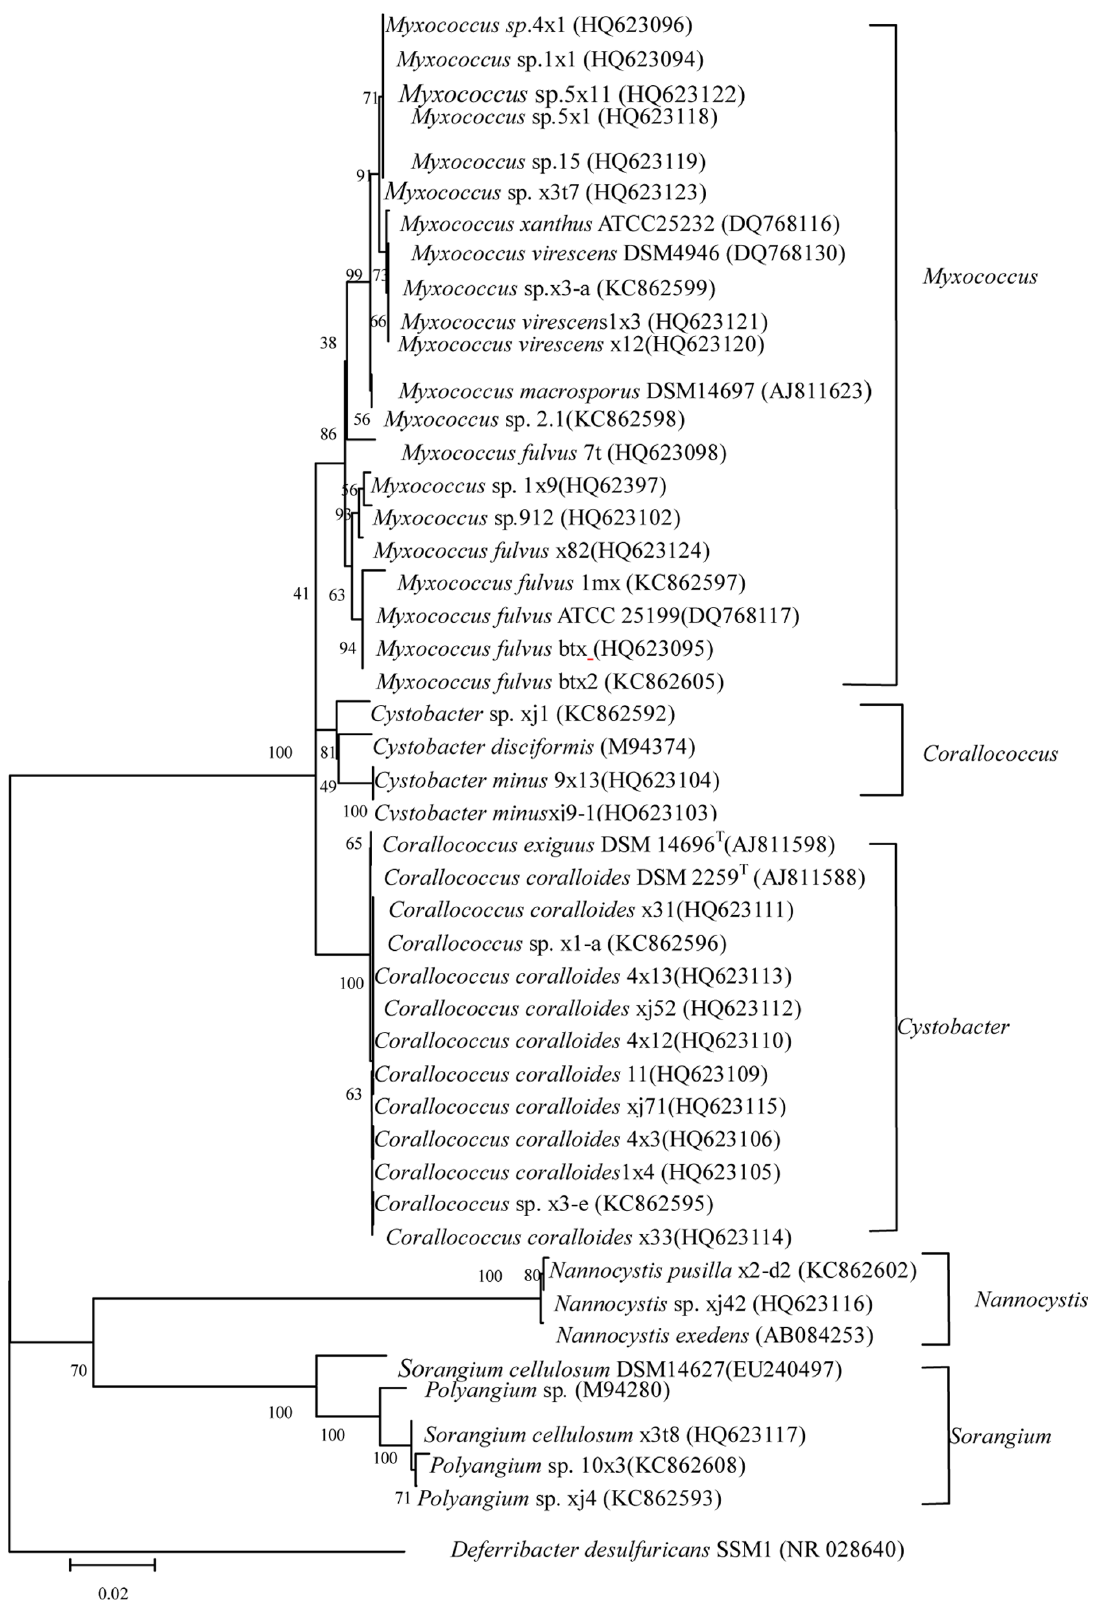
Figure 4. Phylogenetic tree of 36 new myxobacterial strains based on 16S rRNA gene sequences.